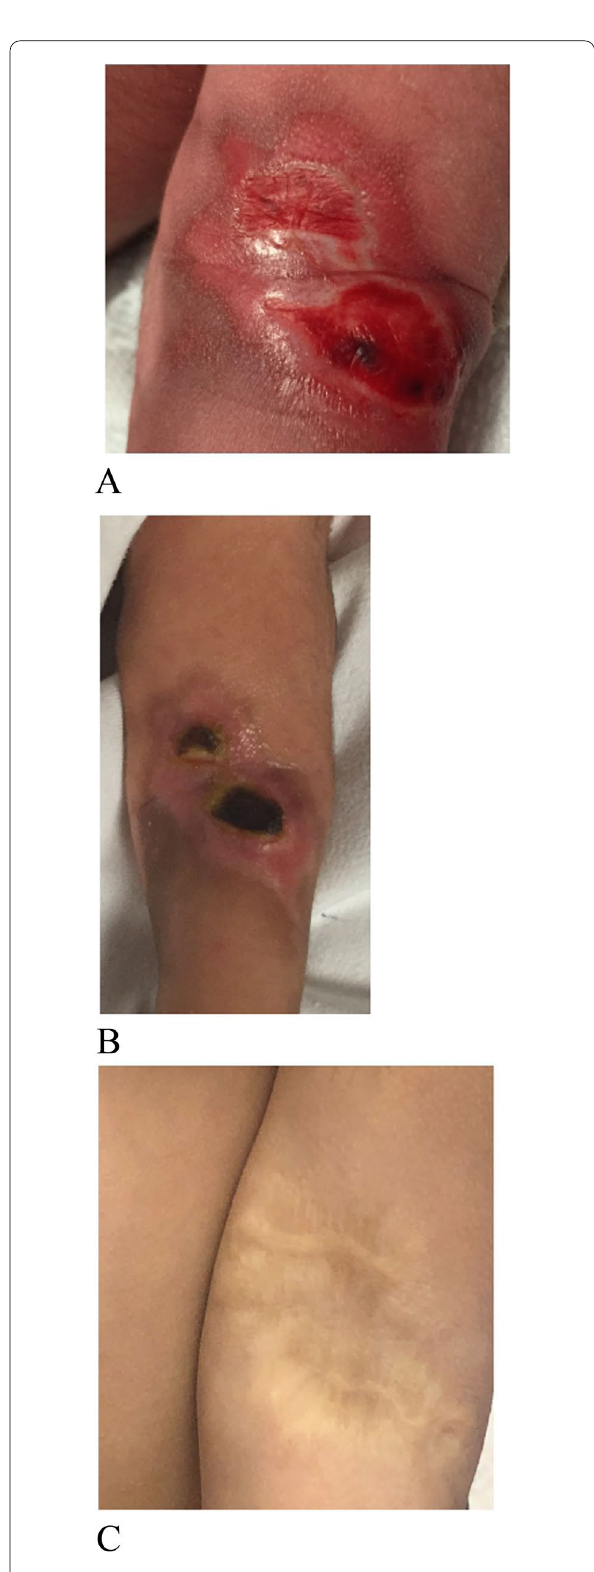
Fig. 4 Patient 4. A Skin defects in the antecubital fossa present at birth. B Progression 1 month after birth. C Mature scars after 3 years of